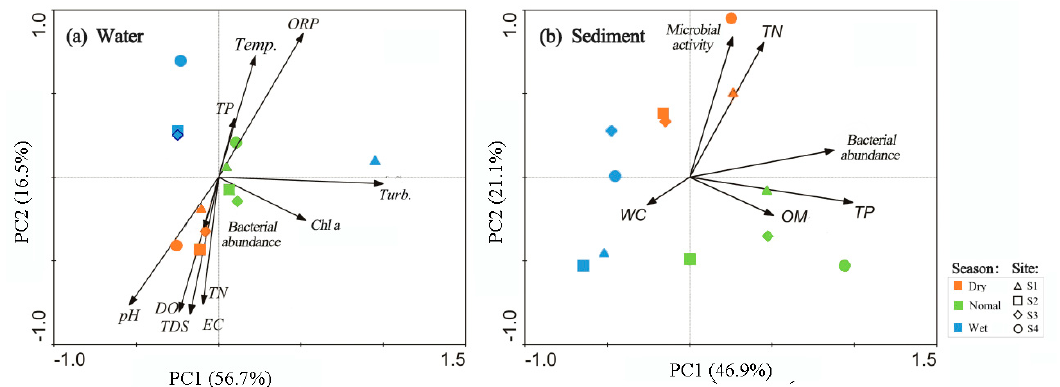
Figure 4. Principal component analysis (PCA) plot of physico-chemical variables in water ( a ) and sediment ( b ) of the sampling sites. EC: electric conductivity; Turd.: turbidity; Temp.: water temperature; WC: water content; OM: organic matter; ORP: oxidation–reduction potential.